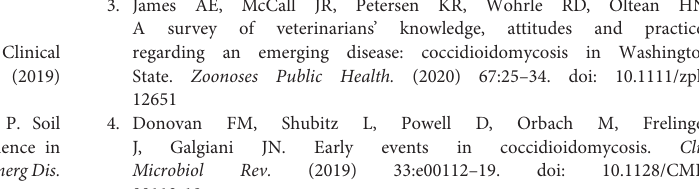
Supplementary Figure 1 | Representative intraoperative images from a cat with a compressive Coccidioides spp. spinal granuloma. (A) Post hemilaminectomy and durectomy. There was no extradural or intradural-extramedullary pathology but the spinal cord was edematous and discolored (open arrow); (B) Immediately post myelotomy. The spinal cord was edematous with suggestion of intramedullary disease (open arrow); (C) Post myelotomy. With initial exploration, the granuloma was partially extruding from within the cord parenchyma (open arrow); (D) Post myelotomy. The granuloma was fully removed from within the cord parenchyma (open arrow), but the cord appeared discolored with the possibility of focal necrosis (closed arrow); (E) the discoloration of the spinal cord dissipated after several minutes (closed arrow); (F) Close-up of the removed granuloma measuring approximately 0.75cm in